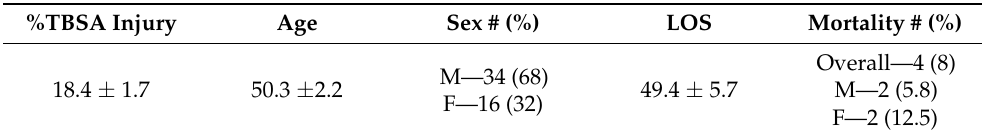
Table 3. Clinical features of human burn injury patients. Key: TBSA-Total body surface area; LOS-Length of Stay; Mean ± SEM.